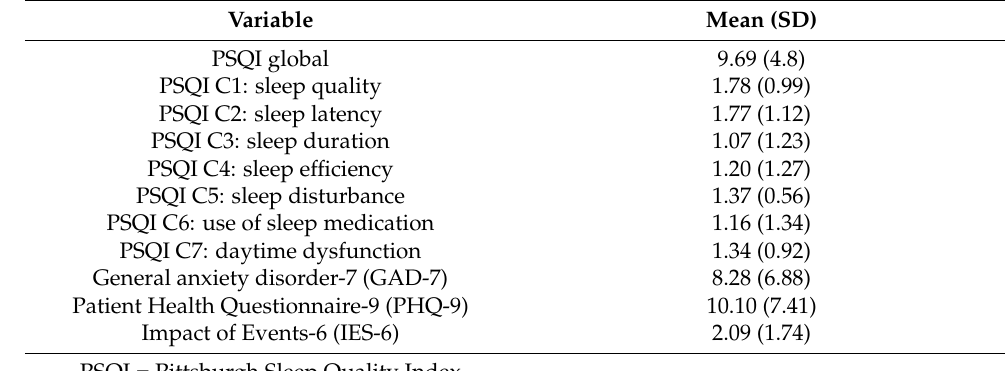
Table 2. Descriptive statistics of sleep quality and outcome